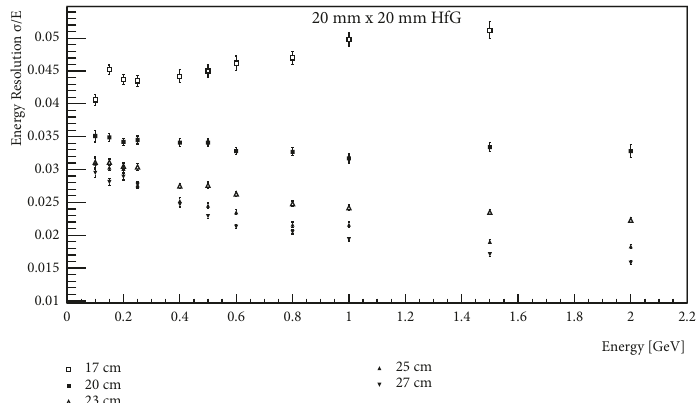
Figure 4: Energy resolutions as a function of beam energy for HfG with 20 mm x 20 mm back face area and five different thicknesses.